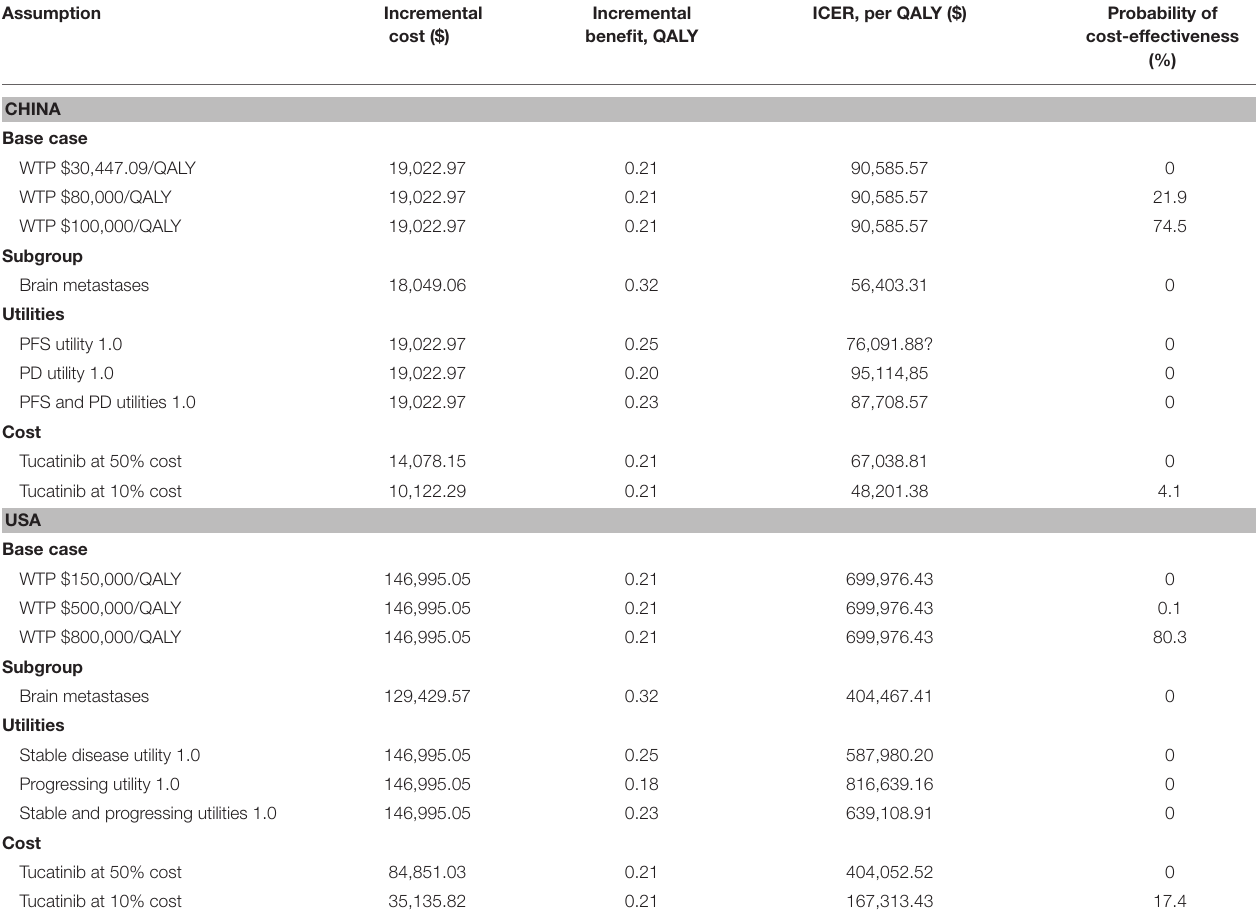
TABLE 2 | Summary of one- and multi-way deterministic and probabilistic sensitivity analyses. Assumption Incremental